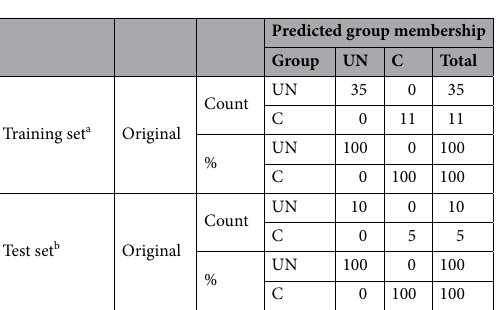
Table 1. Training and test sample confusion matrix for 2-class, AFB 1 -contaminated (C) and control (UN) seeds, classification results. a 100% of selected training cases correctly classified. b 100% of test original grouped cases correctly